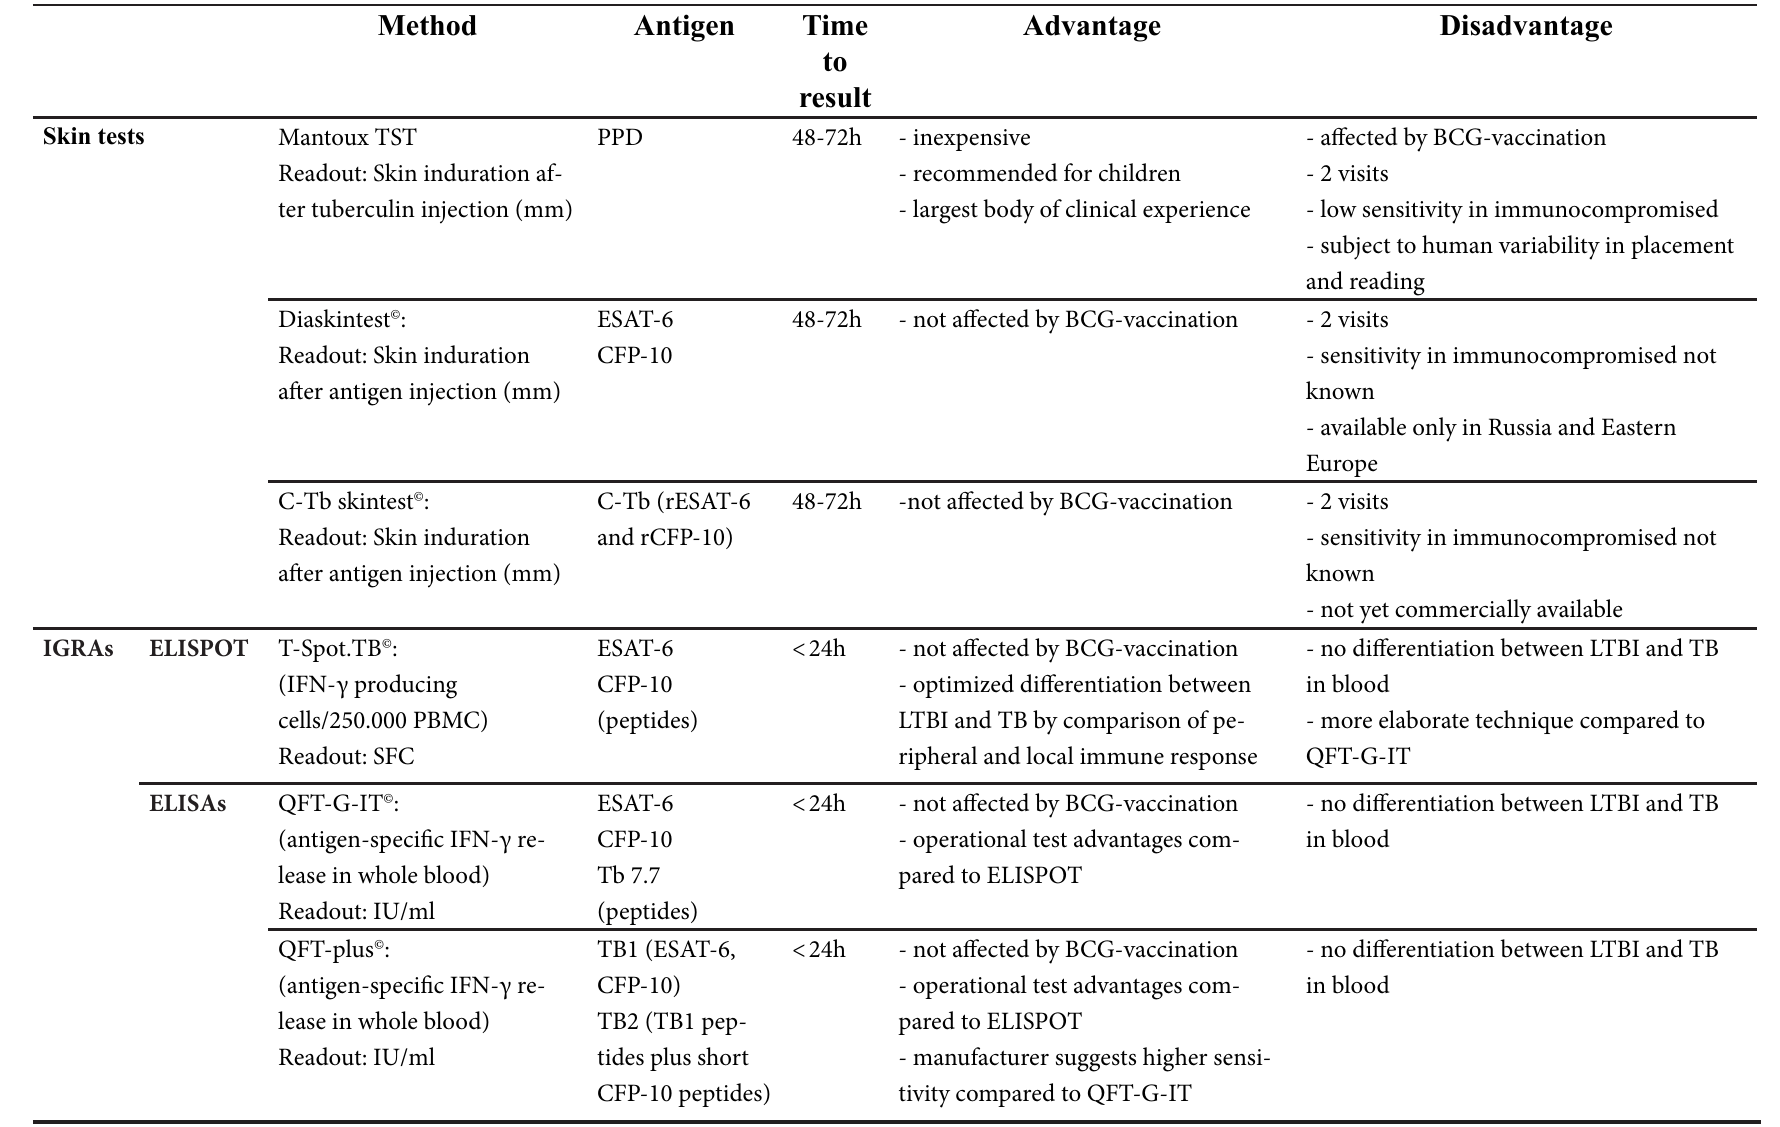
Table 1. Comparison of immunodiagnostic test